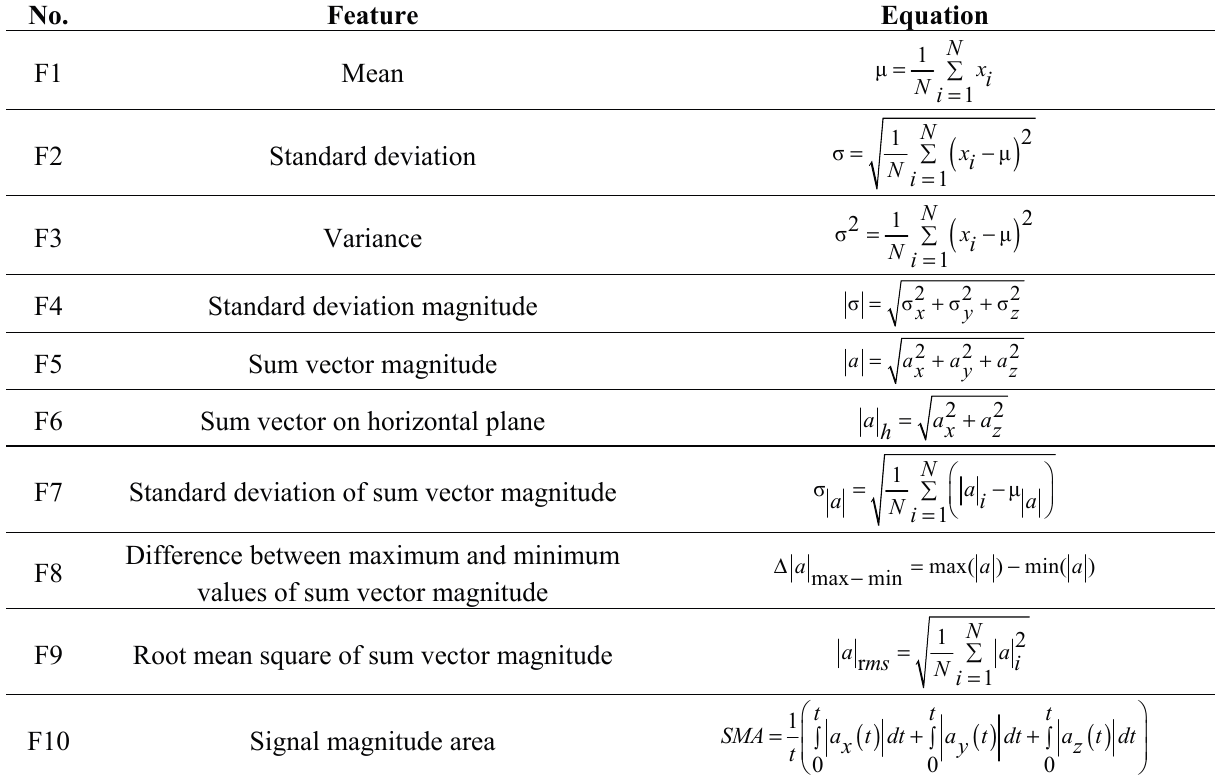
Table 4. Features for fall detection